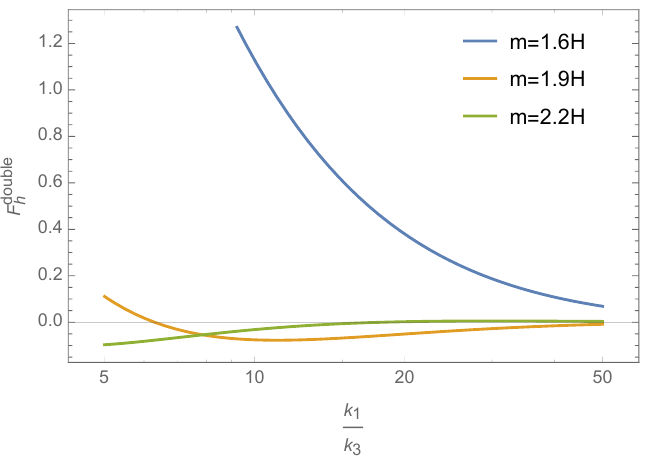
(2.18) for di(cid:11)erent masses in Goldstone h